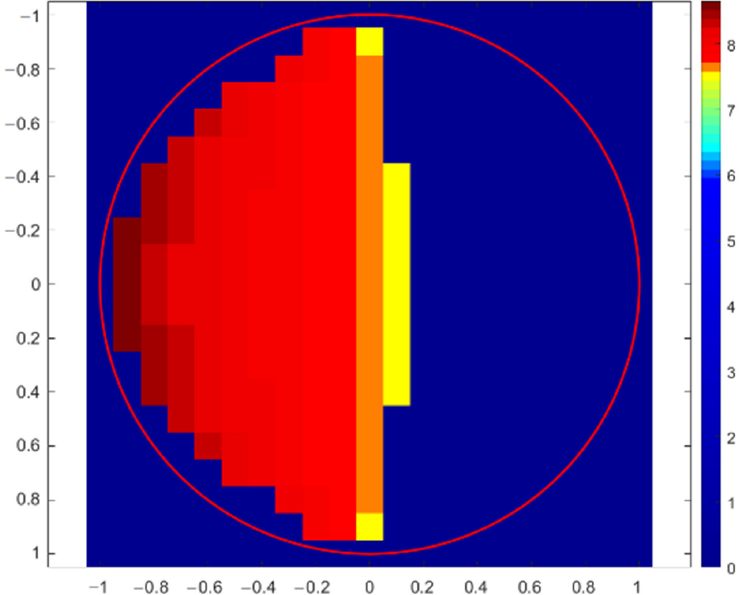
Figure 9. Copper concentration map of sterling silver sphere-shaped hole determined with Monte Carlo simulation of XRF scanning applying Cu-K α and Ag-L lines. The correct Cu concentration was 7.5%.